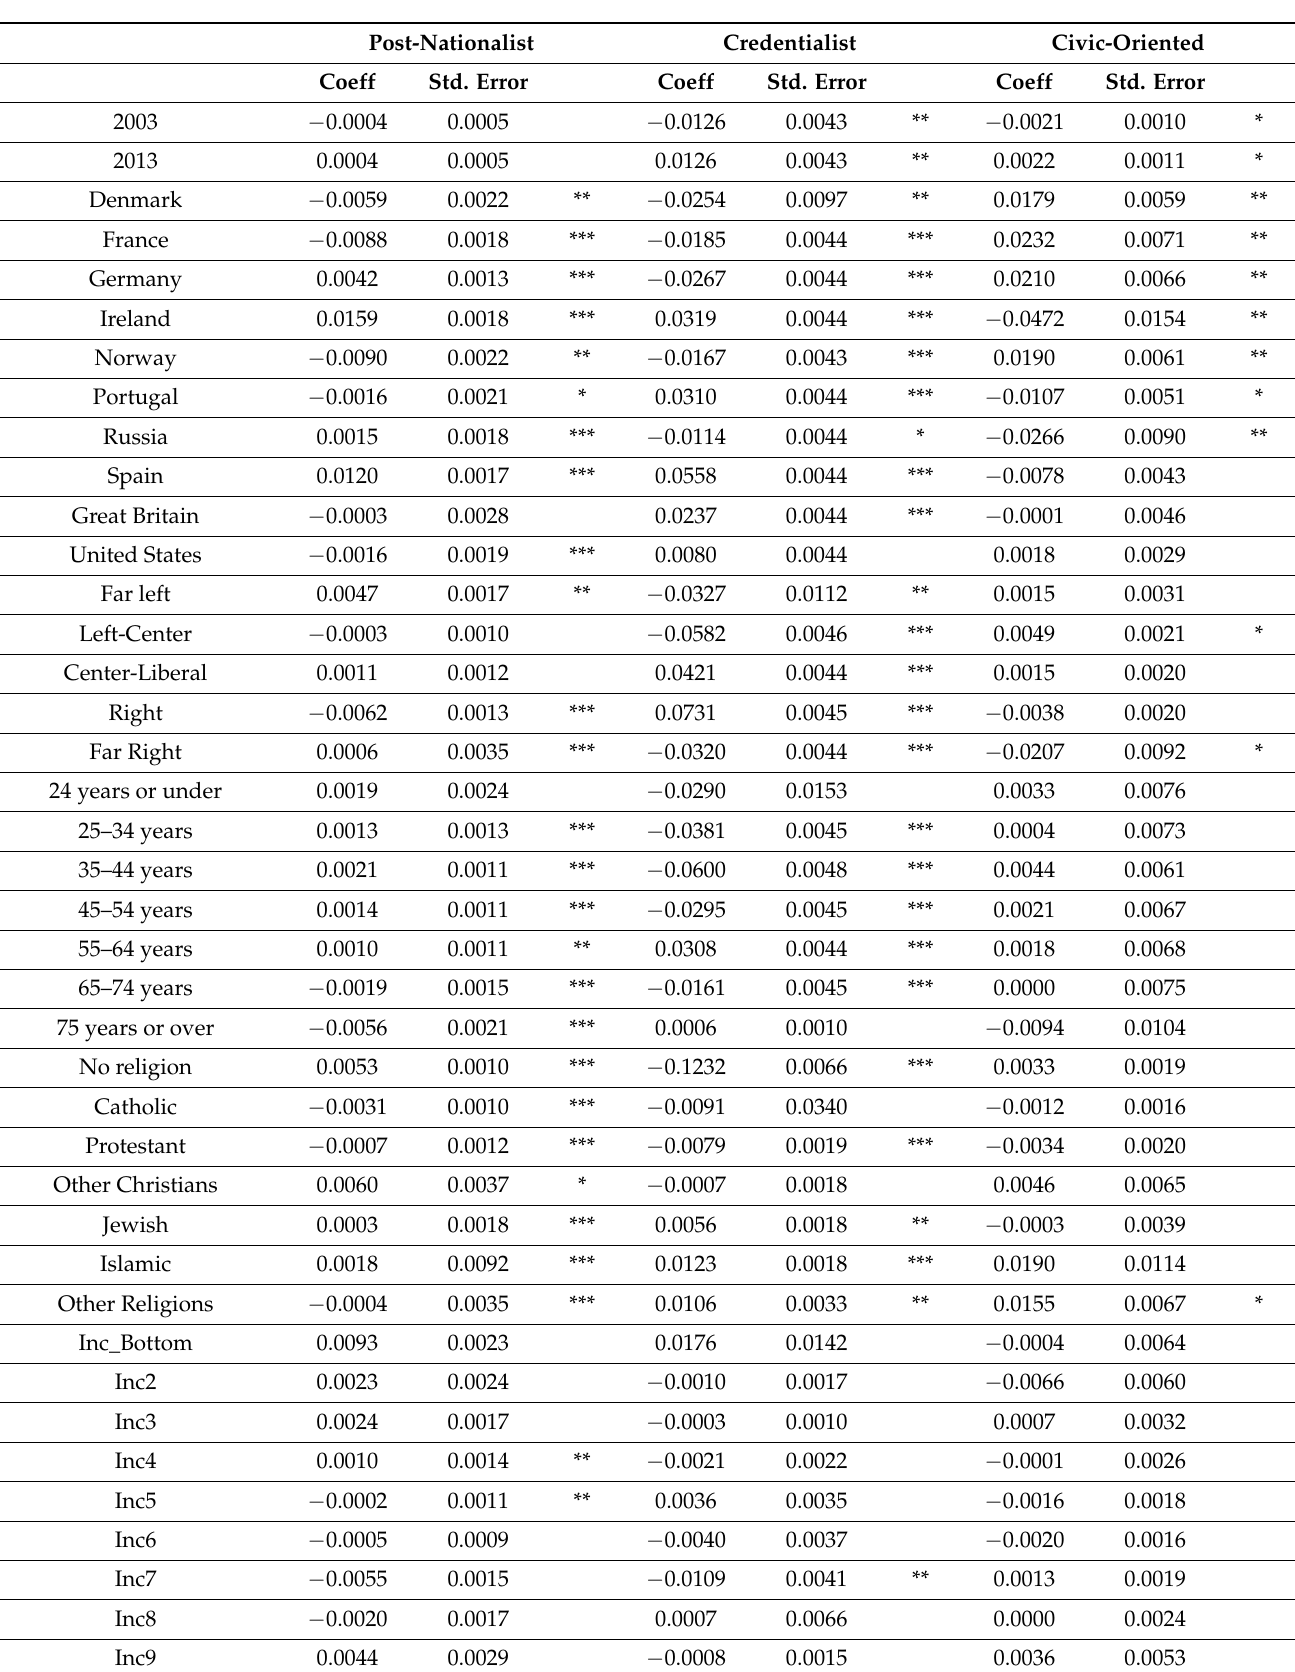
Table 5. Probit model. Marginal